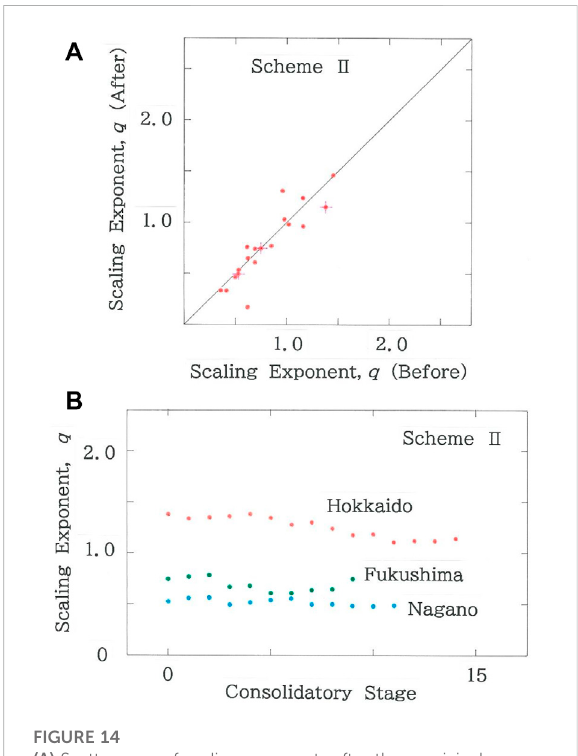
FIGURE 14 (A) Scattergram of scaling exponents after the municipal consolidations according to Scheme II versus those before consolidation ( R = 0.8936 with d = 2.575). The crosses that are superimposed on the dots highlight the three prefectures in (B) . (B) Dependence of scaling exponent, q , on the consolidatory stage. Three prefectures (Hokkaido, Fukushima, and Nagano Prefectures) are selected from (A) , which are discriminated, respectively, with the red, green, and blue